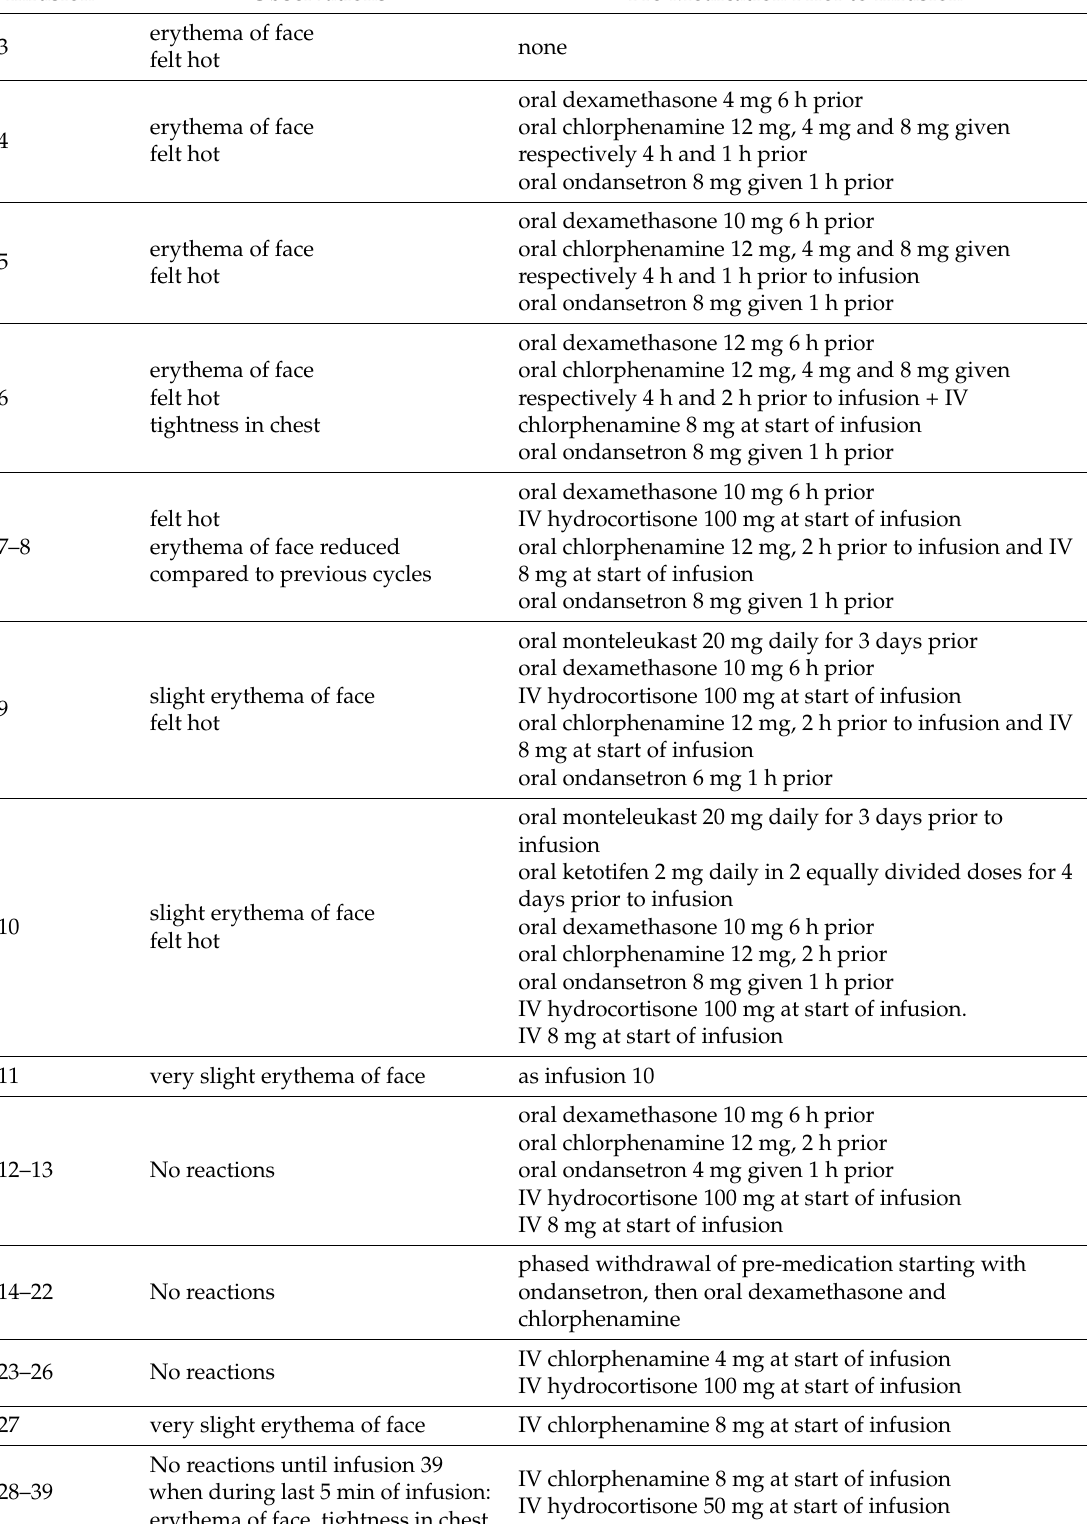
Table 6. Adverse reactions to EE-TP administration in Patient